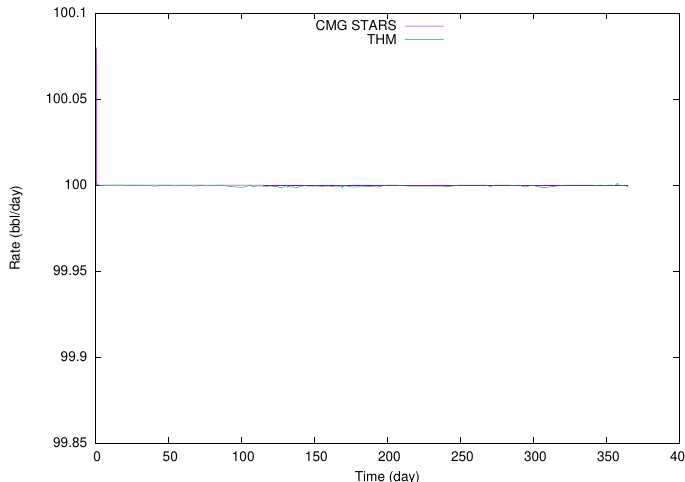
Figure 2. Example 1, injection well, water injection rate (bbl/day).